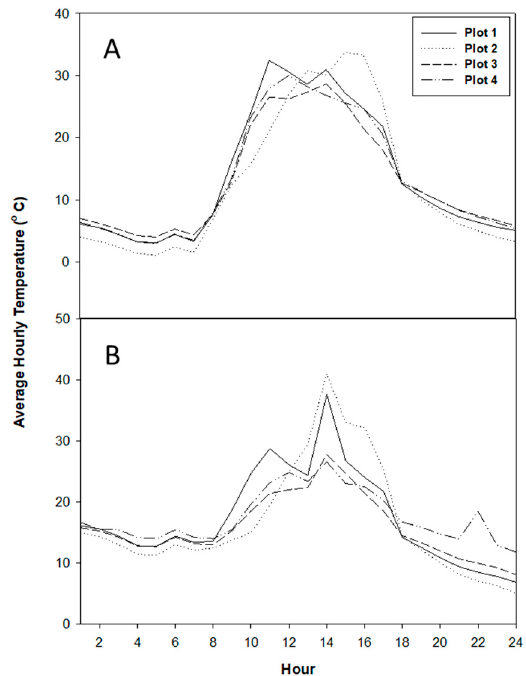
Figure 6. Temperature (averaged hourly) dynamics over 24 h of a day in the plots, recorded 10 days before the burn day ( A ) and on the day of burn ( B ).